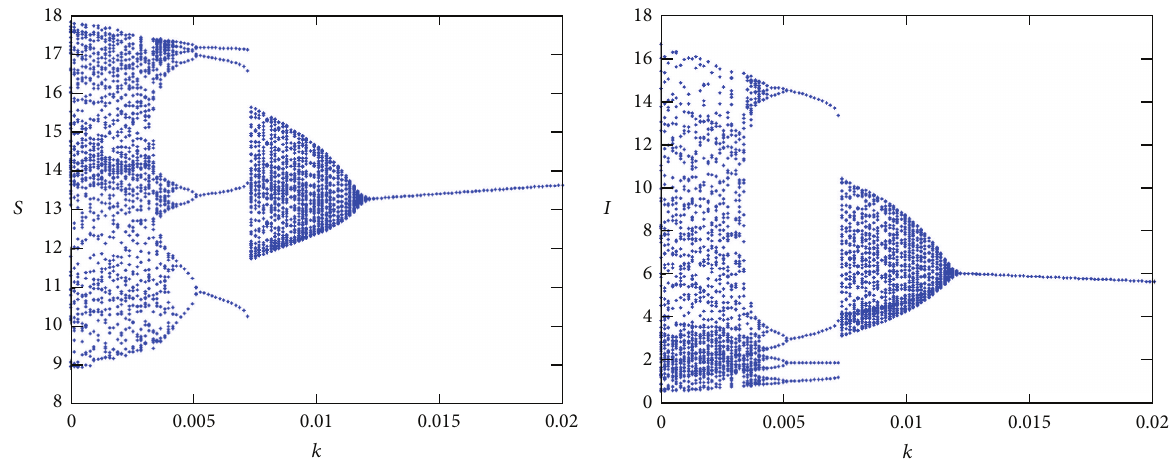
Figure 6: Bifurcation diagrams of system (8) with respect to 𝑘 in case (2) of Section